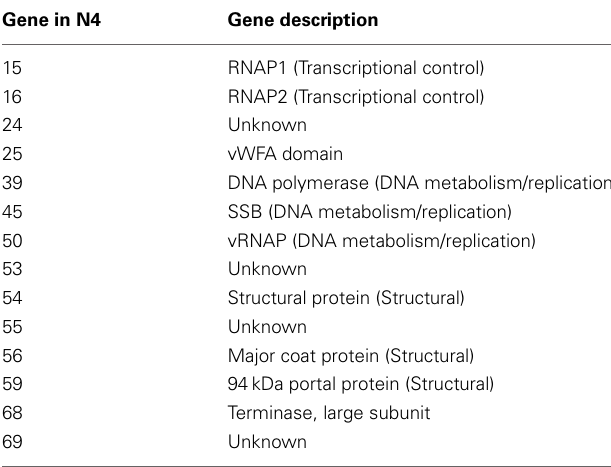
Table 3 | Conserved core genes of the N4-like phage genus.